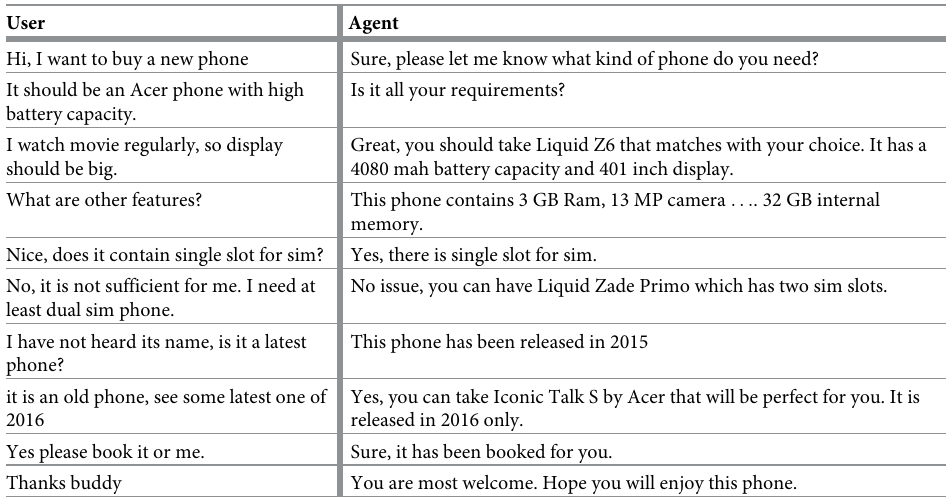
Table 4. Sample dialogue conversation